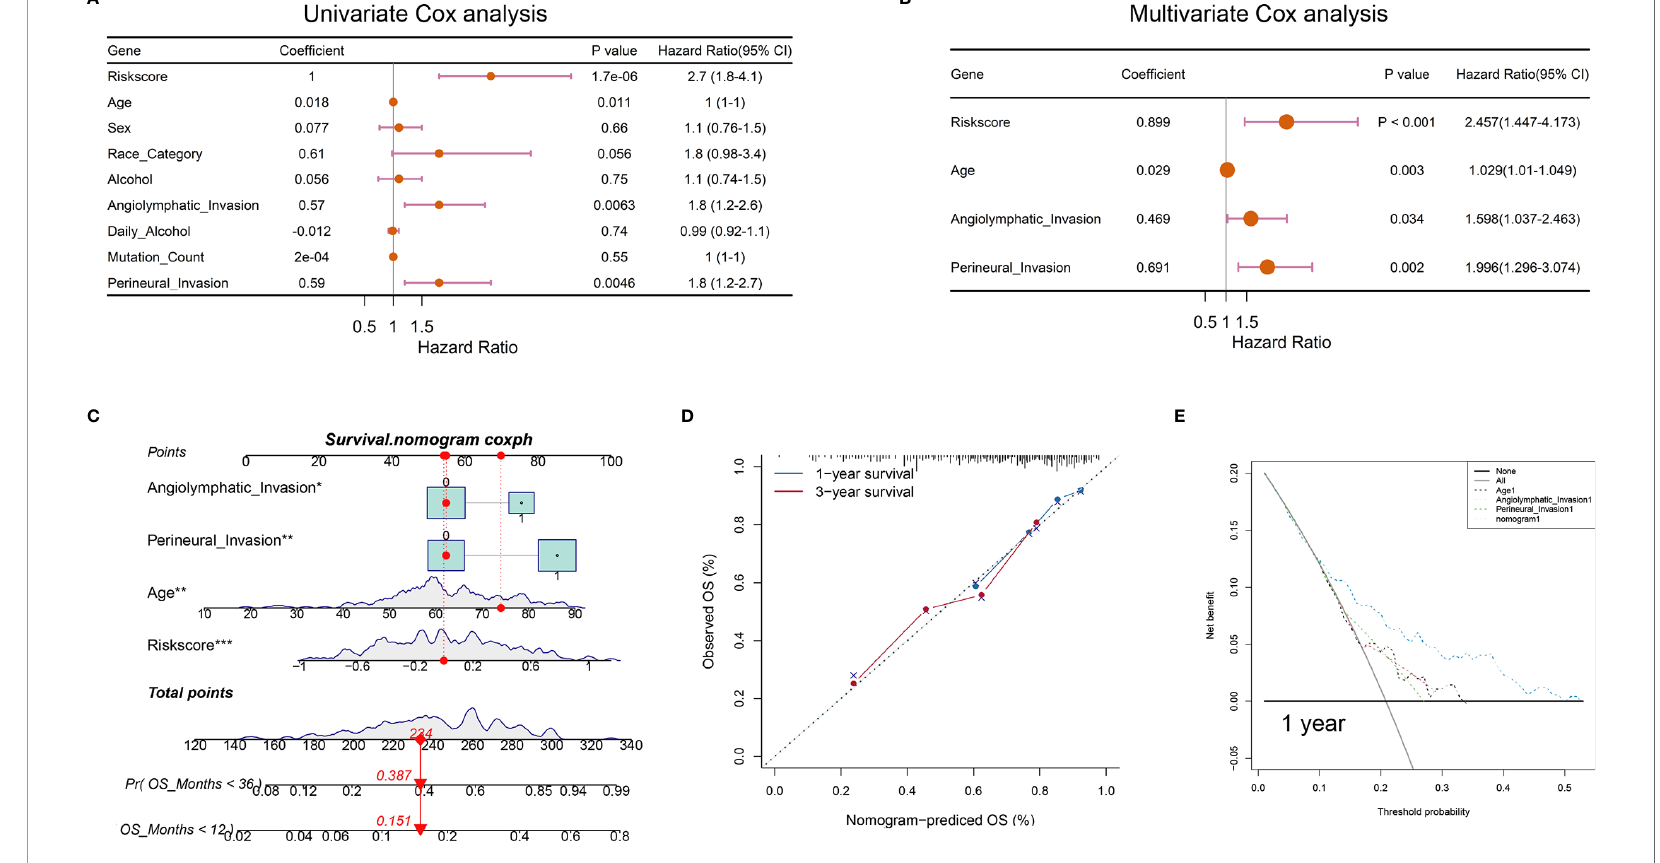
FIGURE 7 | Nomograms according to the OS-associated hypoxia scores for OSCC patients in the TCGA cohort. (A, B) The univariate and multivariate Cox regression analyses of OS-associated variables. (C) Establishment of a nomogram to predict the OS of OSCC patients. (D) The calibration curve revealed the high consistency between the nomogram-predicted OS with actual OS. (E) Decision curve analysis for the nomogram and other clinical features in the prediction of prognosis of OSCC patients at 1-year point (* P < 0.05, ** P < 0.01, *** P <